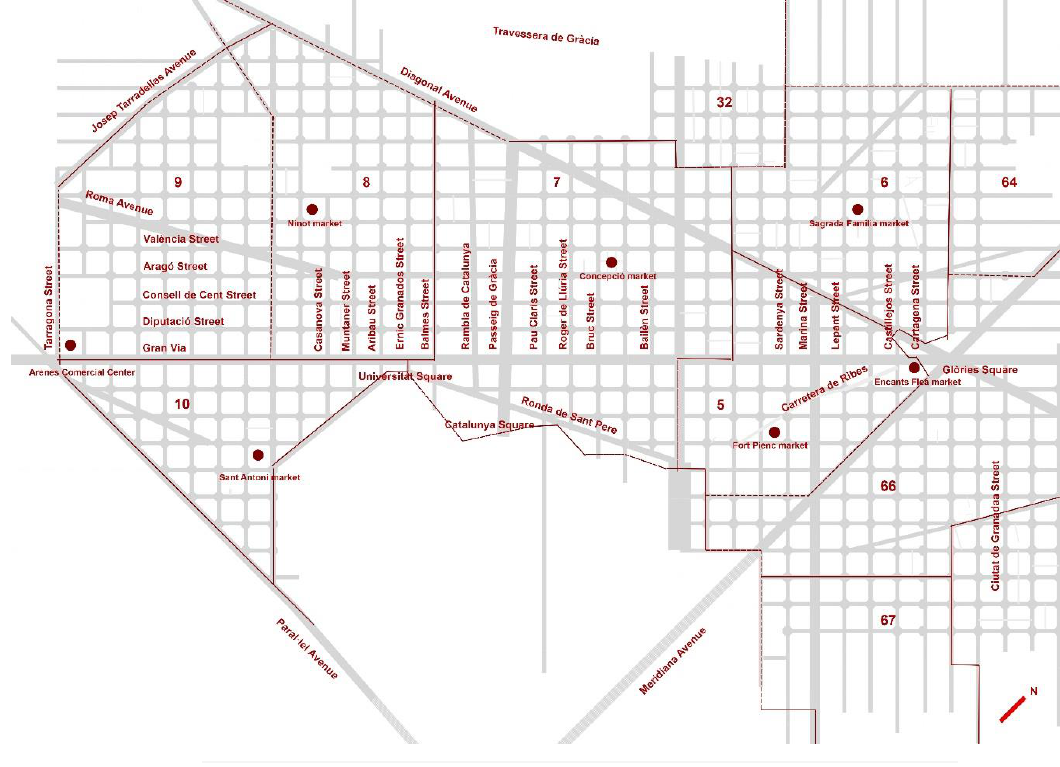
Figure 8. Eixample street layout and nomenclature of the main axis mentioned in the text.